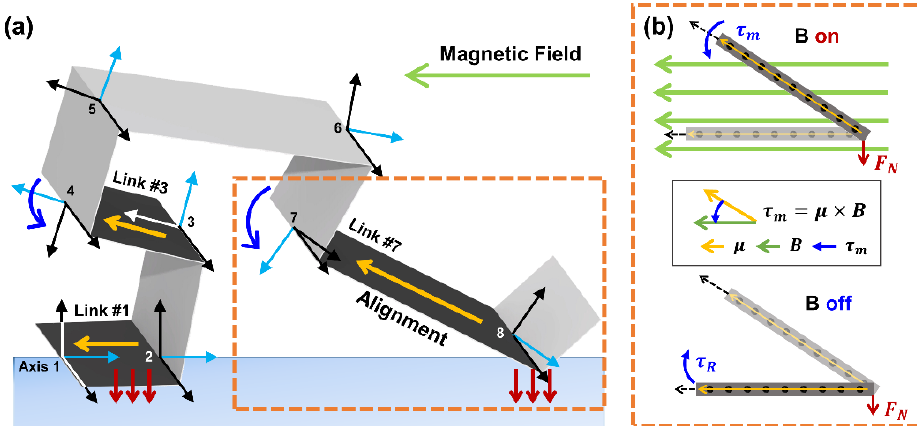
Figure 1. ( a ) Kinematic representation of the proposed walking soft robot; coordinate definition and geometric discretization of the robot. Blue axis means x-coordinates, other axes mean y-, z-coordinates. Black planes are where the magnetic polymers are attached, and red arrows are the normal force of the robot. ( b ) Schematic diagram of the of torque generation mechanism using magnetic polymer and magnetic field alignment. ( τ : Torque, µ : Magnetic moment of MPs, B : Magnetic field).